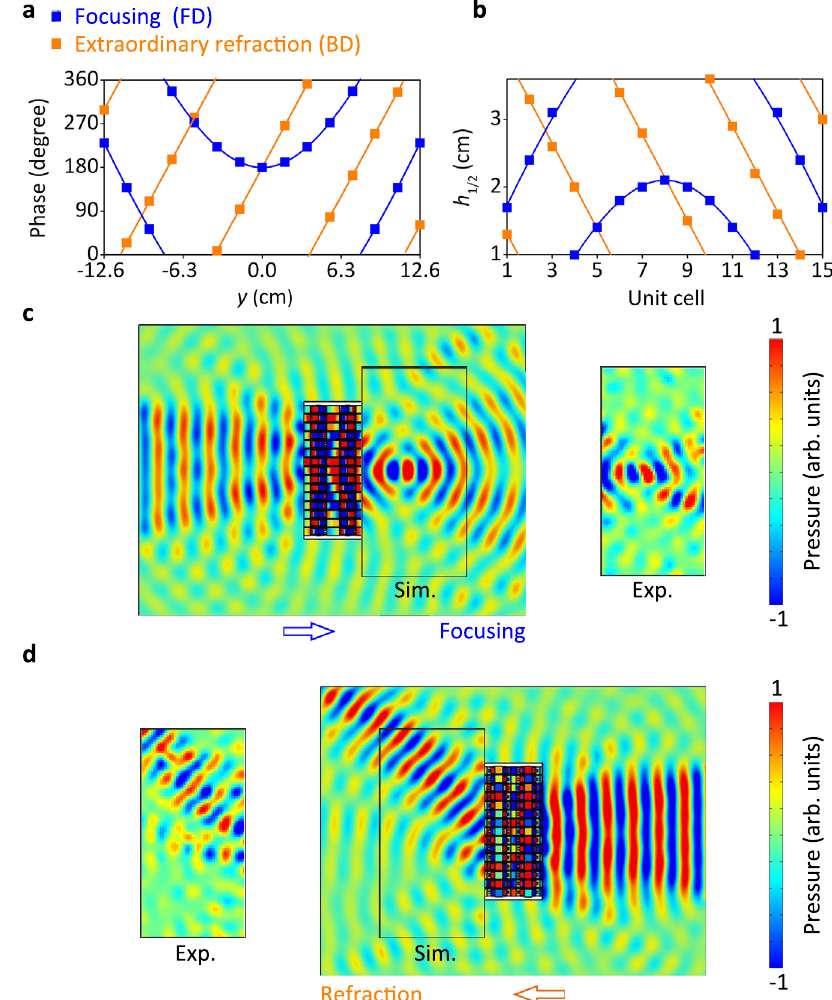
Fig. 7 Two-faced wavefront manipulation, encoding focusing for FD (forward direction), and extraordinary refraction for BD (backward direction). a The phase pro fi les along y -direction of acoustic focusing for FD and extraordinary refraction for BD are φ 1 = 117.8(( x − 0.1) 2 + y 2 ) 0.5 − 11.78 + π rad, and φ = 83.3 y + π rad, respectively. b Corresponding h h 2 1 and 2 values for FD and BD, respectively. c , d Corresponding simulated (sim.) and experimental (exp.) acoustic pressure distributions at 6430 Hz for PD in ( c ) and BD in ( d